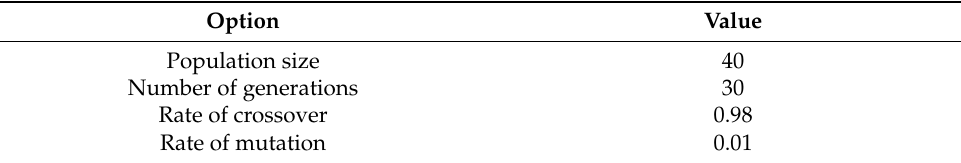
Figure 8. Optimisation process. Table 5. Parameter settings of DNSGA.